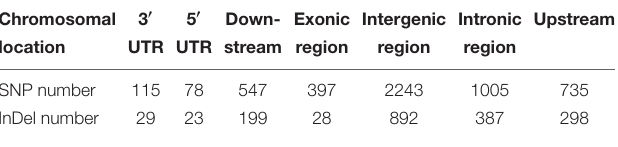
TABLE 3 | The chromosomal locations and numbers of SNPs and InDels in the target QTL region associated with powdery mildew resistance between the melon parental lines wm-6 and 12D-1.